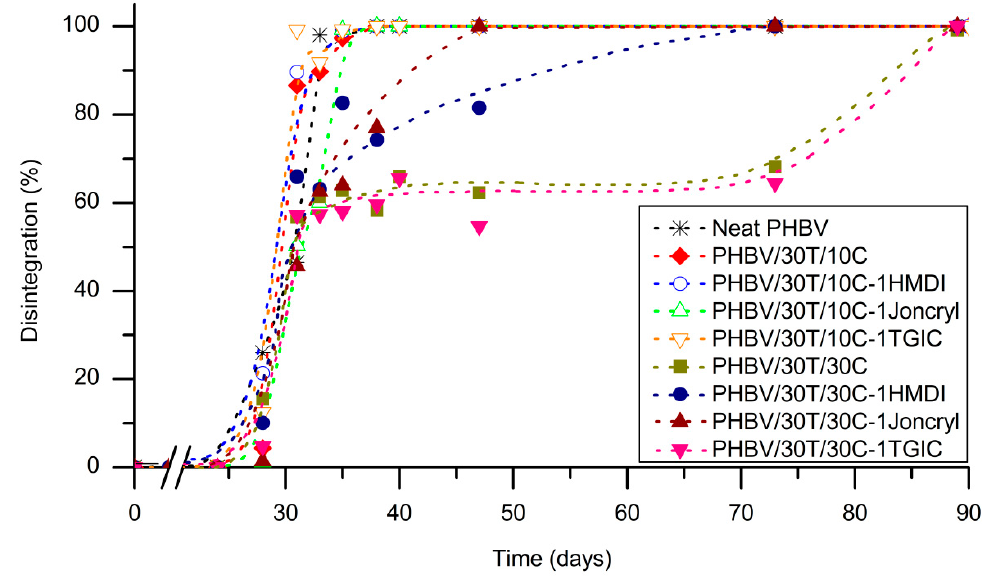
Figure 9. Disintegration in composting conditions of neat PHBV and PHB/TPU/cellulose systems with and without 1 phr reactive agents.